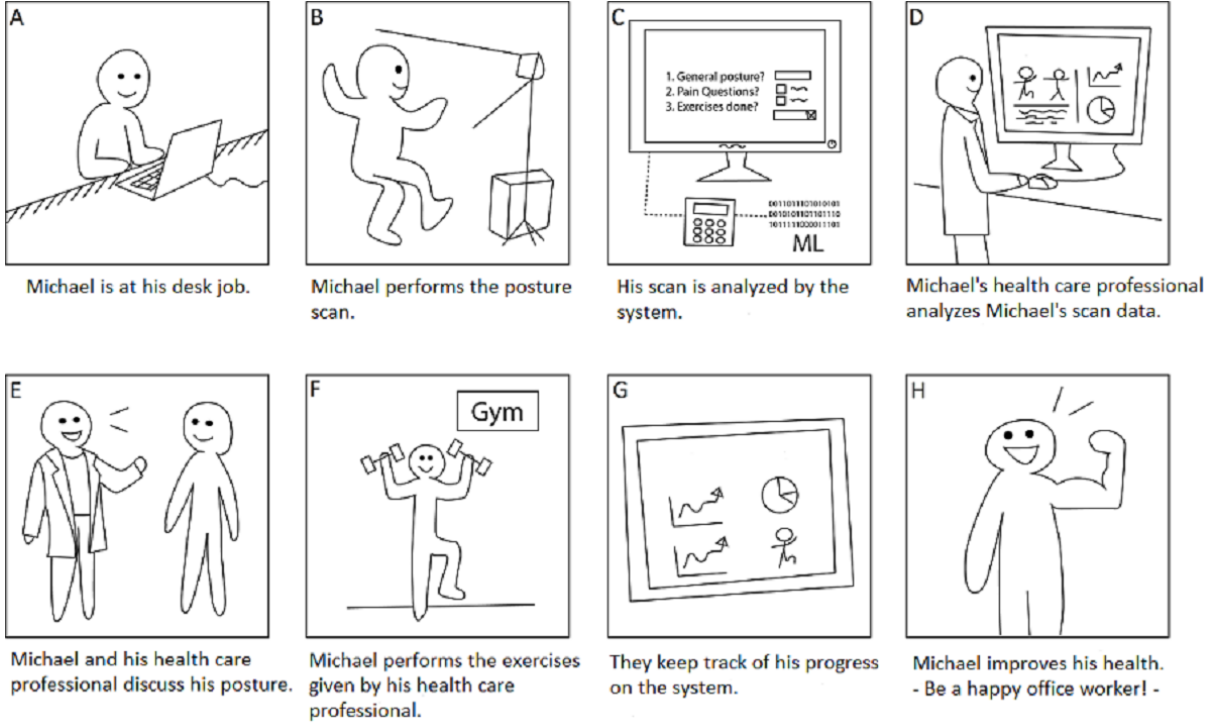
Figure 1. Storyboard depicting the use of posture scanning in the physiotherapy care